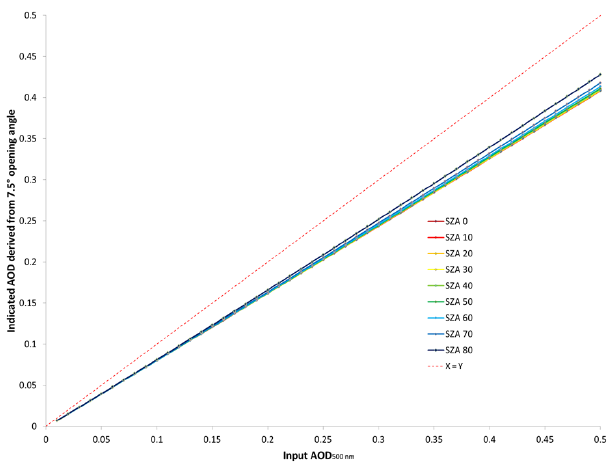
Figure 8. Theoretical AOD computed from measured I N according to the SMARTS2 (Gueymard, 2001) model, when using a 7.5 ◦ FOV detector. The different coloured lines represent different solar zenith angles. Indicated AOD instead of AOD to be consistent with the